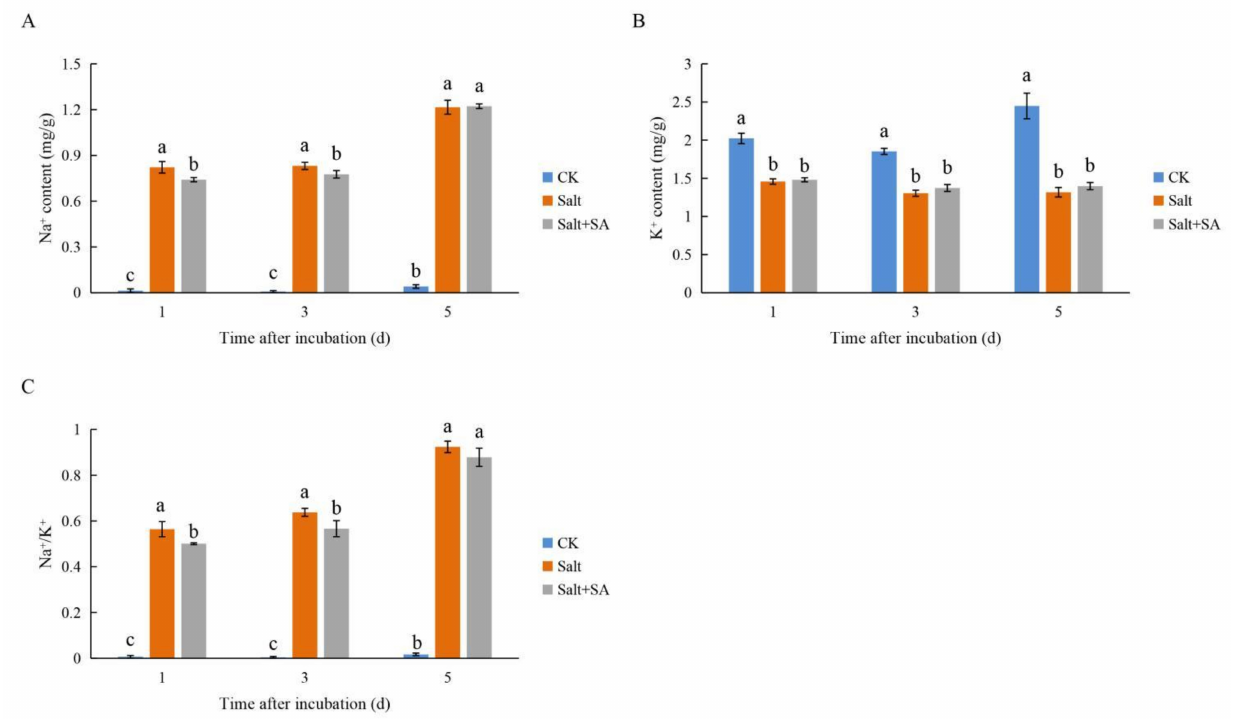
Figure 3. Effects of exogenous salicylic acid (SA) on ion accumulation in rice seeds under salt stress. Seeds of Nipponbare were incubated in distilled water (CK), 150 mM NaCl (Salt), and 150 mM NaCl + 0.1 mM SA (Salt + SA) for 1, 3, and 5 days. The amount of Na + ( A ) and K + ( B ) accumulated in seeds from the different treatments and incubation times are compared, along with the Na + /K + ratio ( C ). Data are presented as means ± SE. Different lowercase letters indicate significant differences between treatments ( p <